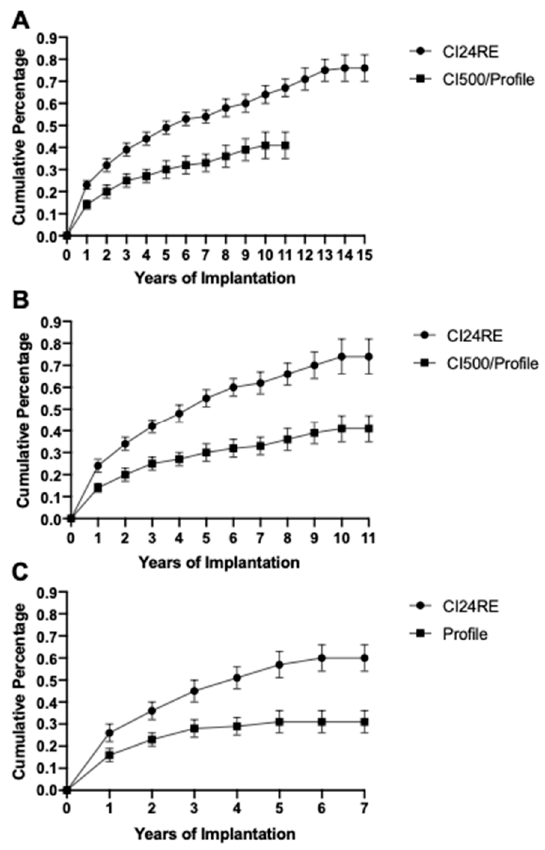
Figure 3. Cumulative percentage of infections leading to explant per year of implantation for Cochlear Nucleus devices before (CI24RE) and after (CI500/Profile) design modifications. Cumulative percentages of infections leading to explant per year since device implantation for ( A ) CI24RE (devices implanted from 2005–2020) or CI500/Profile (devices implanted from 2010–2020); ( B ) CI24RE or CI500/Profile (devices implanted from 2010–2020); ( C ) CI24RE or Profile (devices implanted from 2014–2020). Data are presented as the cumulative failure percentage with 95% confidence intervals. For ( A ) CI24RE ( n = 198,757) or CI500/Profile ( n = 123,084), ( B ) CI24RE ( n = 142,439) or CI500/Profile ( n = 123,084) and ( C ) CI24RE ( n = 80,845) or Profile ( n = 93,189). Table 1. Percentage of infections leading to explant by geographical region